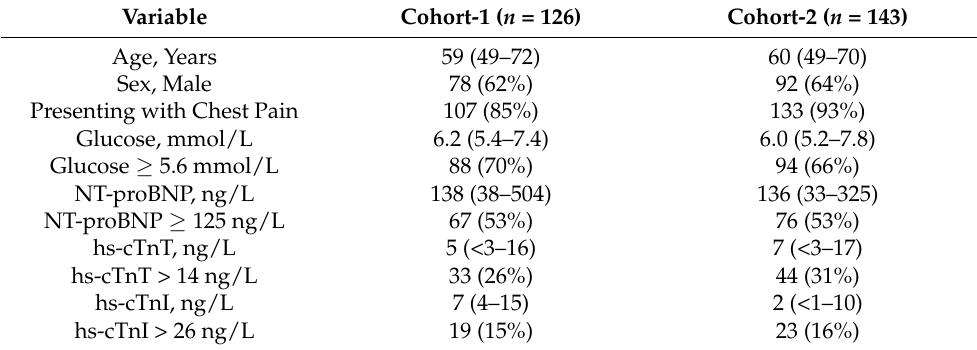
Table 1. Baseline characteristics of Cohort-1 and Cohort-2. Data presented as counts, percentages and median